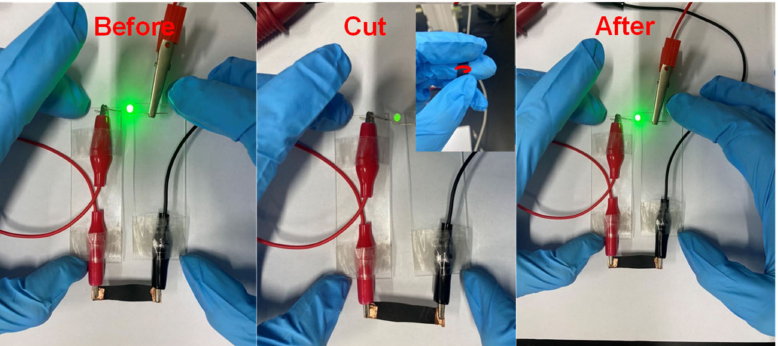
Figure 17. Photographs of LED bead on the composite film before, cut, and after being healed under near-IR